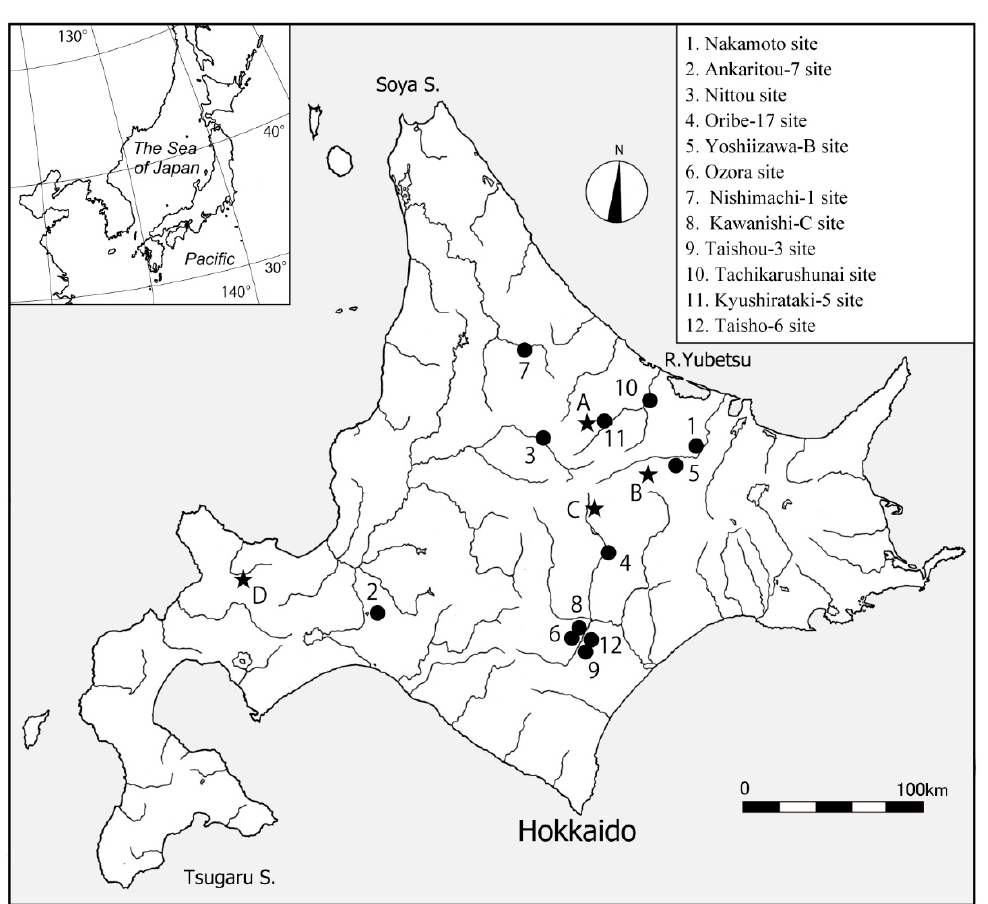
Figure 1. Locations of the sites referenced in this text. Major obsidian sources: ( A ) Shirataki; ( B ) Oketo; ( C ) Tokachi-Mitsumata; ( D ) Akaigawa.